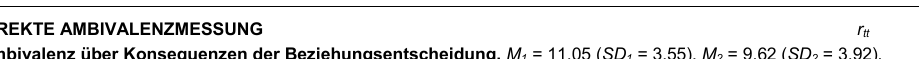
Tabelle 1: Itemformulierungen und